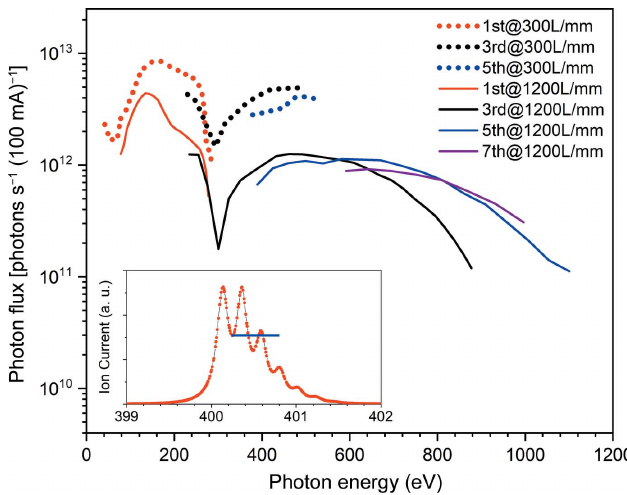
Figure 4 Measured photon flux after the exit slit for two different gratings, 300 lines mm (cid:3) 1 and 1221 lines mm (cid:3) 1 . The beamline opening is 0.15 mrad, the energy slit is 150 m m (H) (cid:6) 300 m m (V). Inset: ion yield spectrum at the N 1 s -absorption edge of N 2